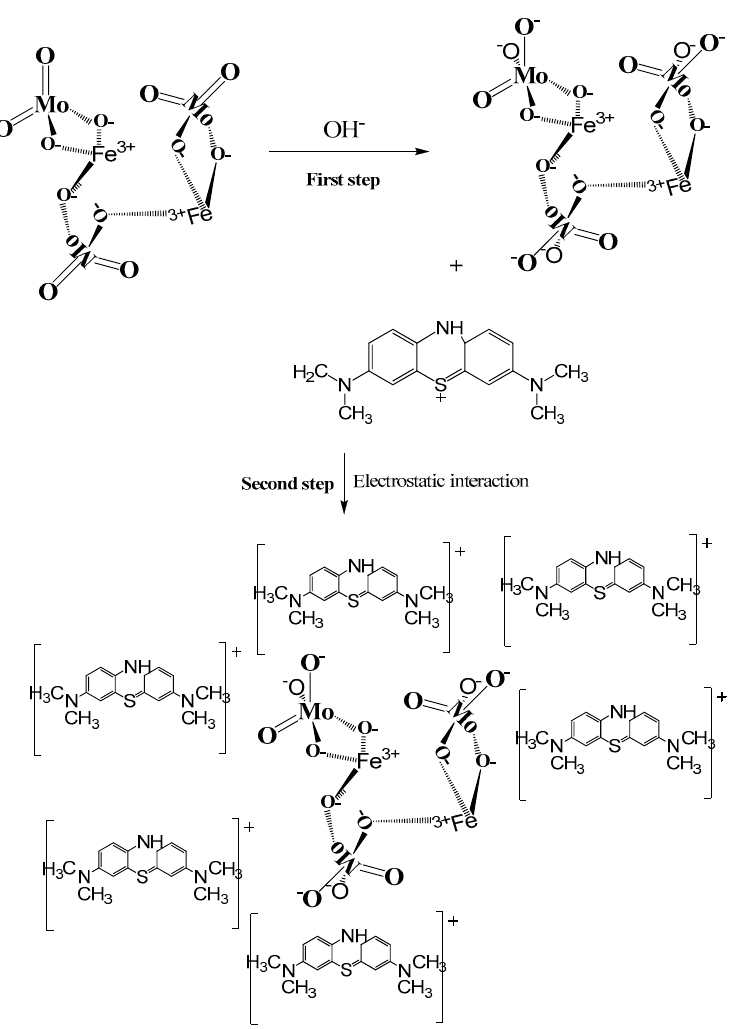
Figure 12. Schematic mechanism of MB dye removal using the iron molybdate nanosorbent.